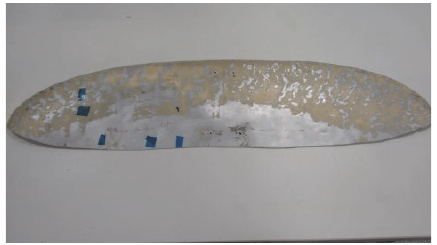
Figure 2: 3D aluminum